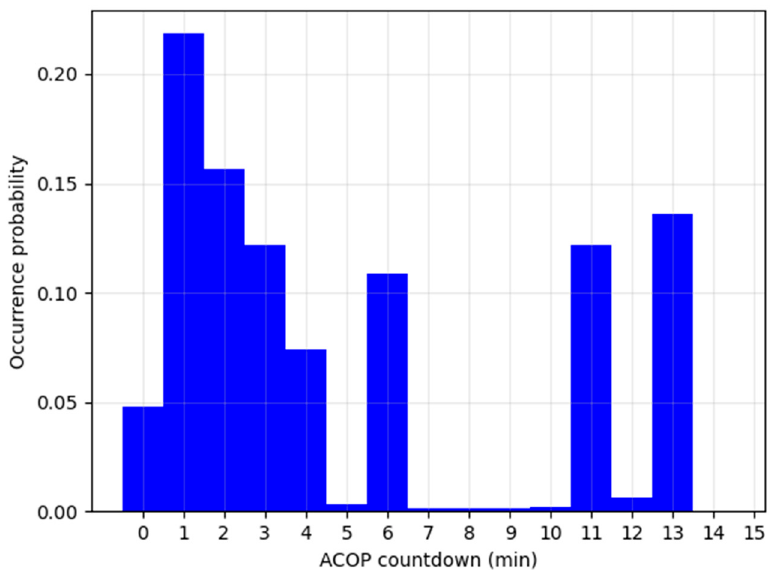
Figure 14. Histogram of the expiration times for the ACOP “Direct To” suggestions.